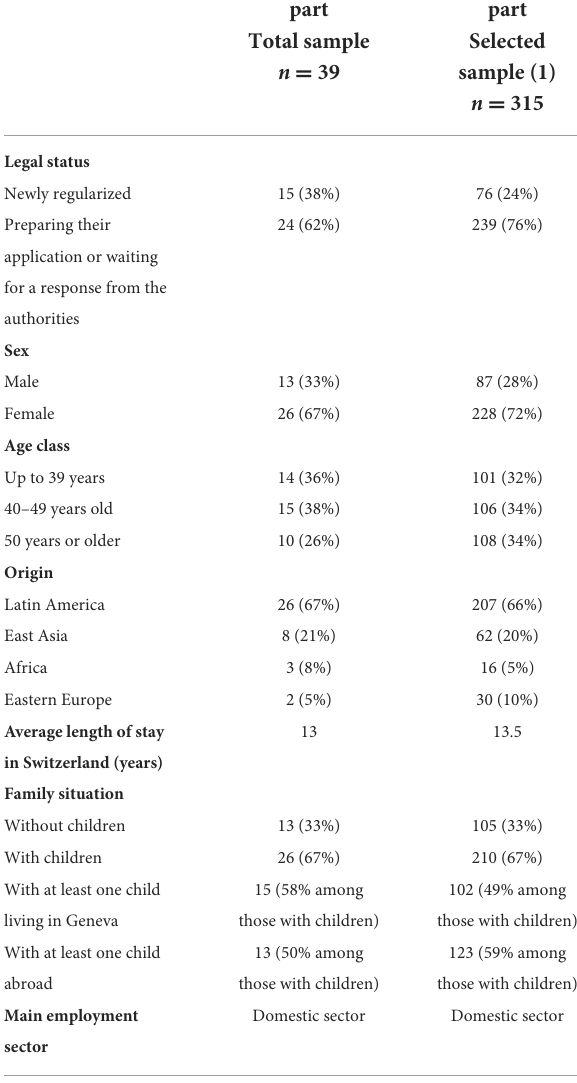
TABLE 1 Characteristics of the qualitative nested subsample of the Parchemins research